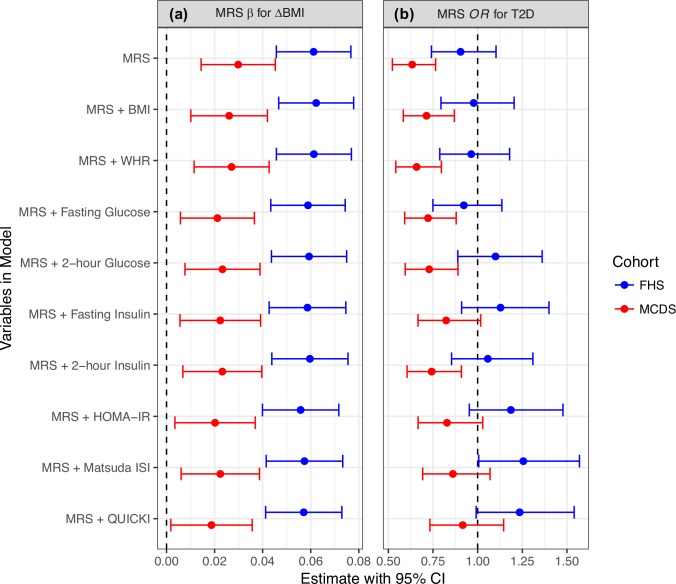
Association between ΔBMI or future T2D status and MRS with adjustment for baseline anthropometric or glycemic measures.(a) Effect size estimates (β) of MRS for ΔBMI. (b) Odds ratios (OR) of MRS for T2D status at follow-up. Variables in Model, which variables were included in the linear (for ΔBMI) or logistic (for T2D) regression model when estimating the effect of MRS. Error bars indicate 95% confidence interval (CI). Vertical dashed black lines indicate null effect (β = 0 or OR = 1).